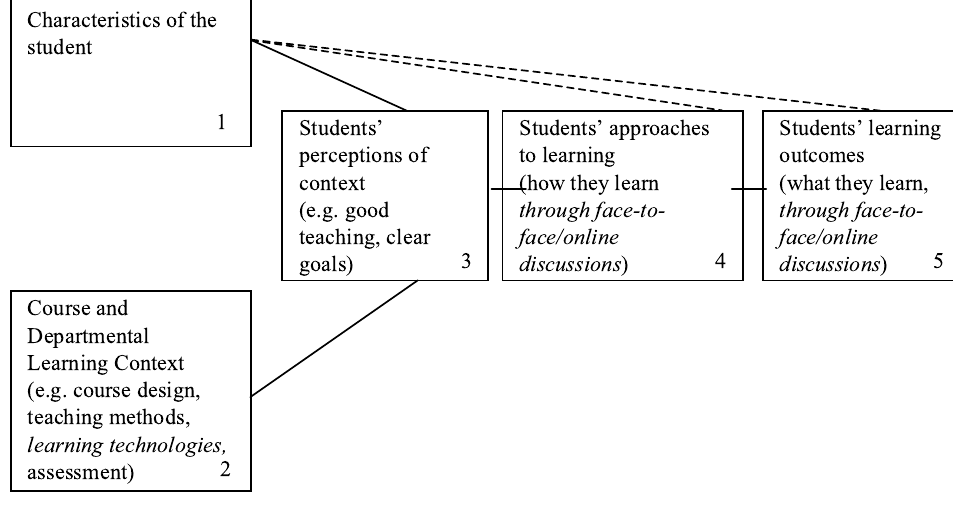
Figure 1. The 3P model of learning (after Trigwell & Prosser,